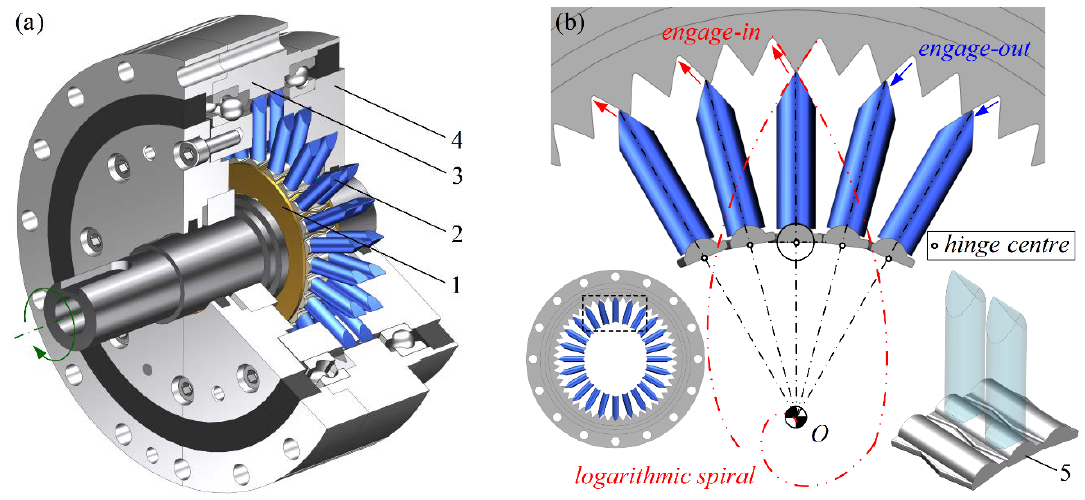
Figure 2. CAD model. ( a ) virtual prototype; ( b ) movable teeth and pivoted